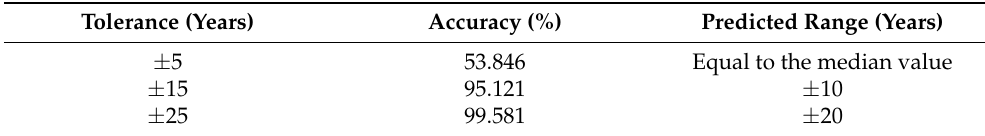
Figure 6. Graph showing the accuracy of the predicted dental age for each tolerance. Table 1. Table of accuracies according to